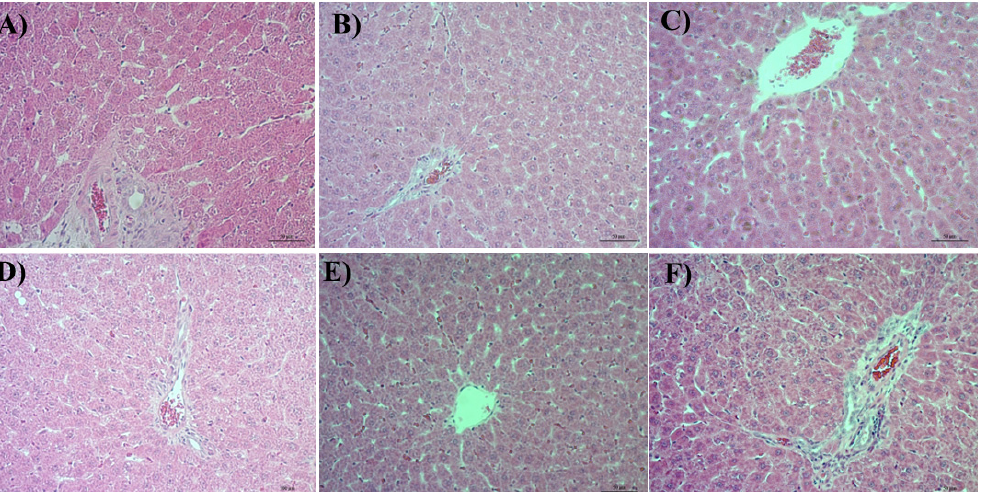
Figure 5. H and E photomicrography (100×) in the region of the hepatic portal system, in which ( A ) Control; ( B ) Green tea (GT); ( C ) GT loaded in nanoparticles of lyotropic liquid crystal (NP-LLC); ( D ) Exercise (Ex); ( E ) GT+Ex; ( F ) GT loaded in NP-LLC+Ex.